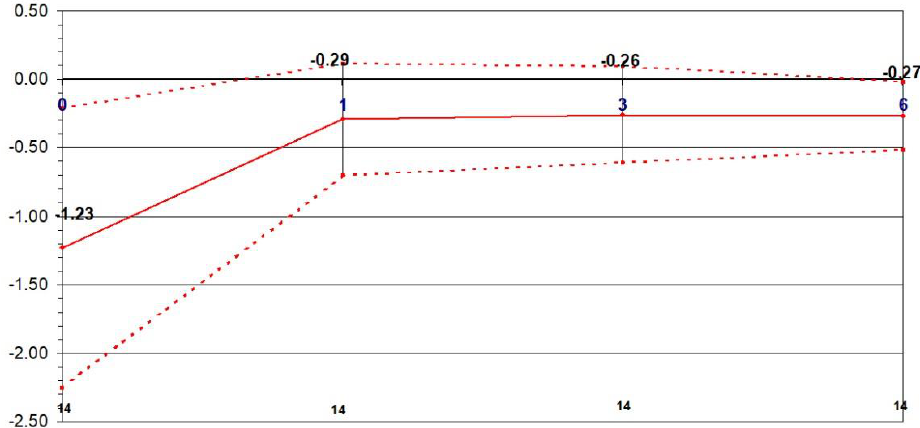
Figure 8. Stability: Change in refraction over time in the non-dominant eye.